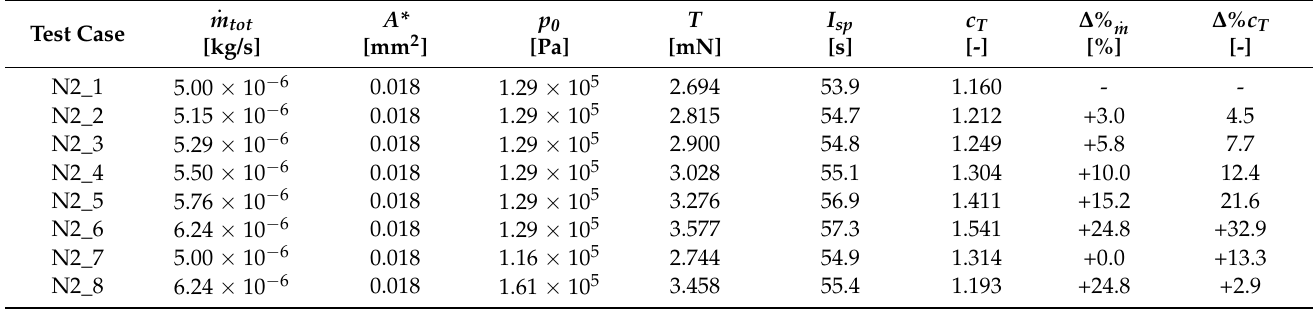
Table 9. Performance analysis of the micro-nozzle: nitrogen gaseous flow.